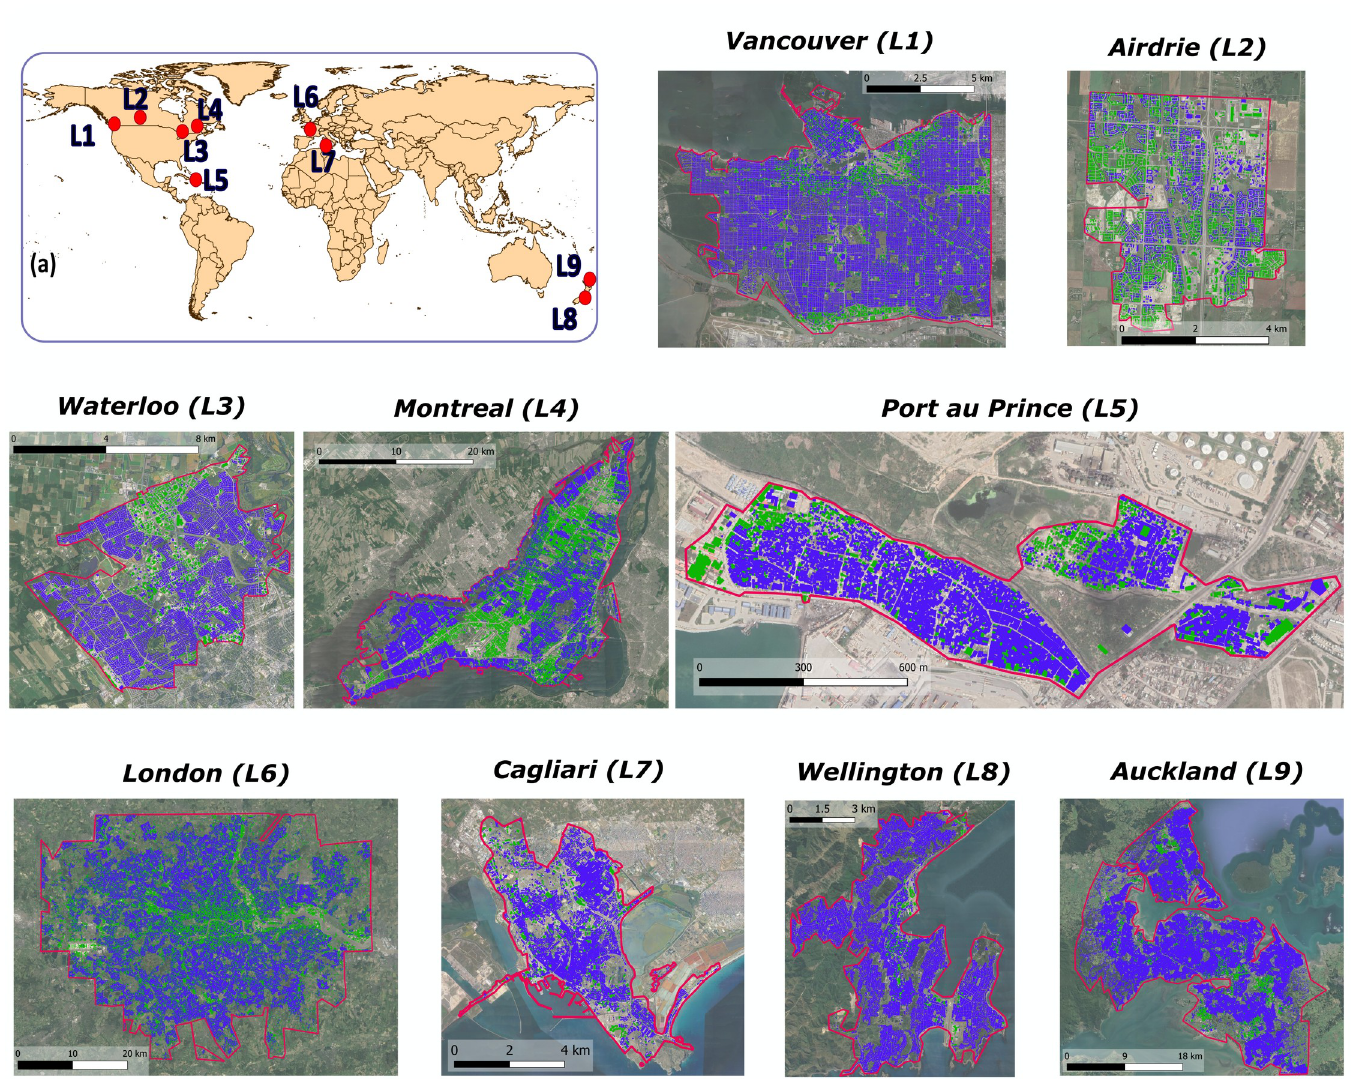
Fig 2. Geographical location of the 9 selected case studies. (a) Location of the 9 cities on a world map. (L1-L9) Boundaries of the study cases with investigated rooftops. Flat roofs are highlighted in green, while sloped roofs are represented in blue. Cities are ordered based on their geographic location from west to east. Maps have been developed with the help of QGIS 3.4 [37], using layers downloaded from the different geoportals listed in the S1 Table and satellite images derived from the Landsat website (http://landsat.visibleearth.nasa.gov/).